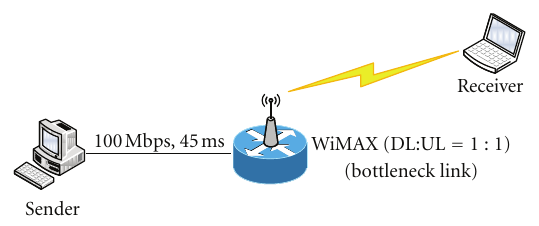
Figure 3: A single TCP flow in a WiMAX network.